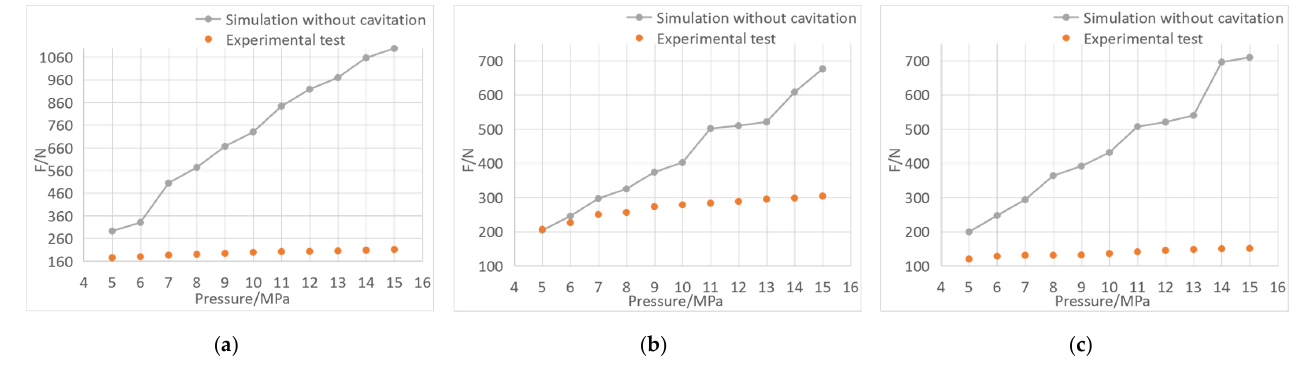
Figure 7. Comparison of suction force results of simulation with non-cavitation model and experiment of suction cup- θ 20. Gap clearance is ( a ) 1 mm; ( b ) 1.5 mm; ( c ) 2 mm.